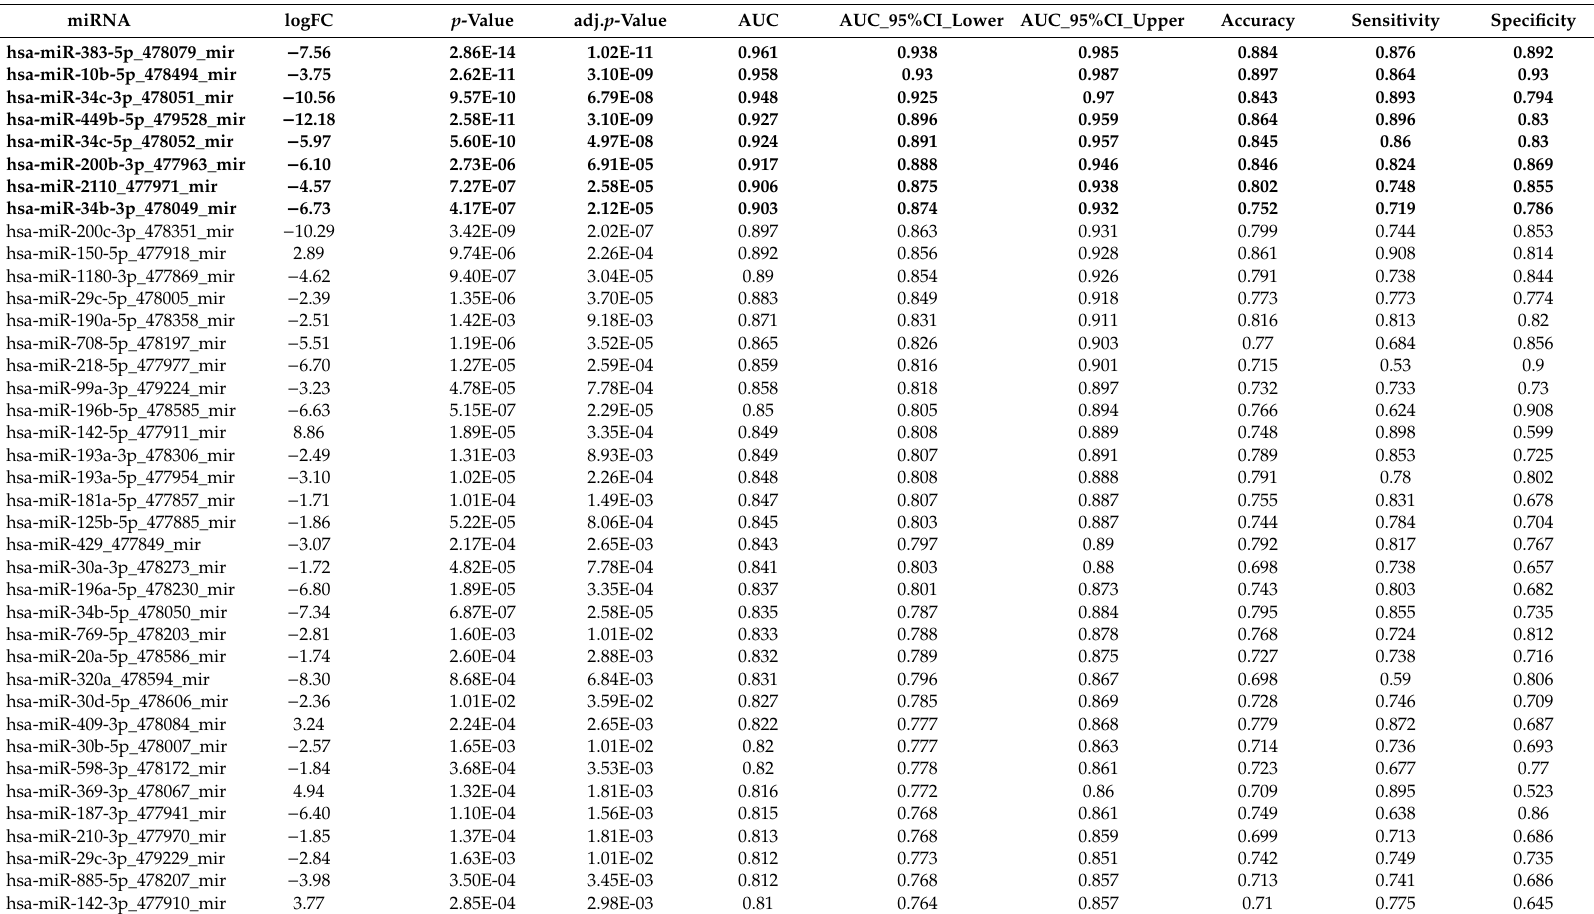
Table 2. List of MicroRNA (miRNA) transcripts displaying a significant di ff erential expression in patients with EC compared to control